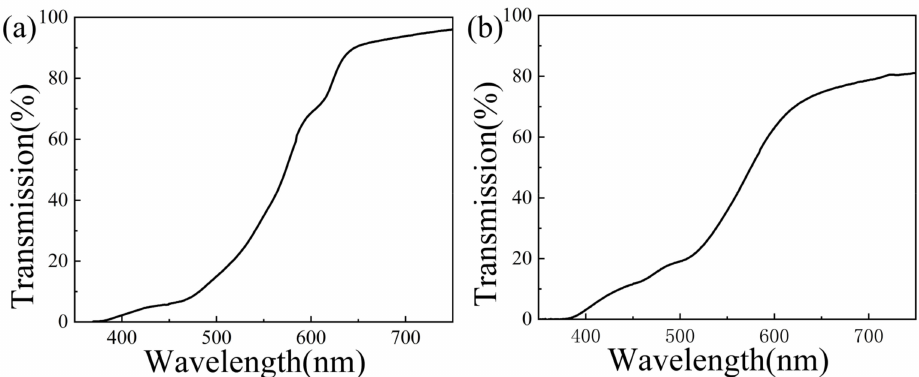
Figure 8. The transmittance spectra of the DLW processed 150 mg/mL red QD–polymer block filter ( a ) and 150 mg/mL green QD–polymer block filter ( b ) at a P of 35 mW and a v of 30 µ